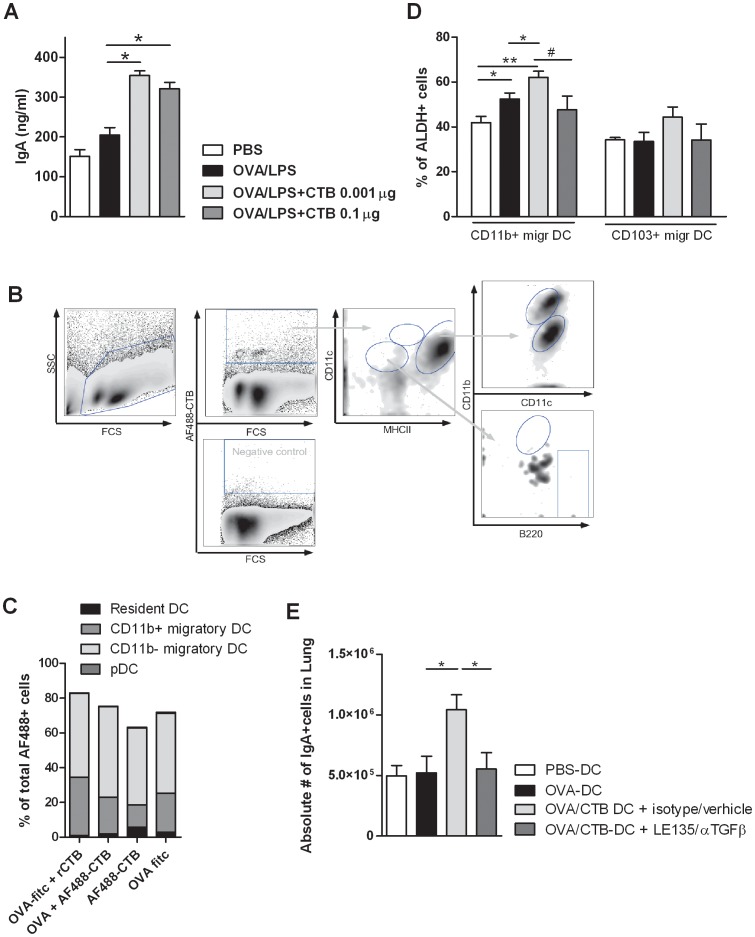
Ex vivo CTB pulsed DCs promote IgA responses in the lungs via RA and TGF-β.PBS, OVA (800 µg/80 µl/mouse), OVA+CTB (0.1 or 0.001 µg/80 µl) or CTB alone were instilled in lungs of naïve mice. (A) After OVA challenge, lung B cells were isolated, cultured and restimulated by LPS (10 µg/ml) for 7 days and IgA levels were determined (B) AF488-labeled CTB (and as a control Fitc-labeled OVA) was used. After 36 hrs, MedLN and lung tissue were studied for the presence of AF488-positive cell populations: Dead cells are excluded based on FSc and SSc; AF488 positive cells selected; migratory cDCs (MHCIIhi) subdivided into CD11b+ and CD11b- subsets; resident DCs (MHCIIint); CD11cloMHCIIlo cells, subdivided into pDC (B220+) and alveolar macrophages (CD11b+) (C) As in B. Percentage of AF488-positive DC subsets total AF488+ cells in MedLN (D) After 36 hrs, MedLN were isolated. ALDH enzyme activity of different DC subsets was determined using ALDEFLUOR assay, by flowcytometry. (E) BM-DC were generated as described and pulsed with PBS, OVA (100 µg/ml), OVA+CTB (10 µg/ml) or CTB only (10 µg/ml) and the next day intratracheally injected in naïve mice. One day before until 3 days after DC instillation, mice were treated i.p with LE135 and anti-TGFβ antibody (or isotype Ab and DMSO). After one week, the mice were challenged by OVA for 3 consecutive days. One day after challenge, the number of IgA+ cells in digested lungs was determined by flowcytometry. Data are mean +/− s.e.m, of at least 2 individual experiments with 4 mice per group (for D: 12 mice per group, pooled per 3 mice, resulting in 4 datapoints per group). # p = 0.10 * P<0.05, ** P<0.01, *** P<0.001.